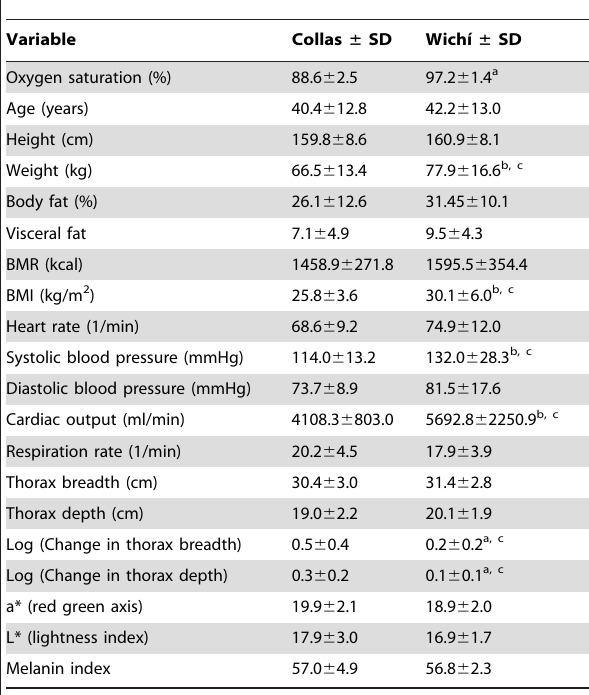
Table 3. Comparison of variables between Collas and Wichı´.